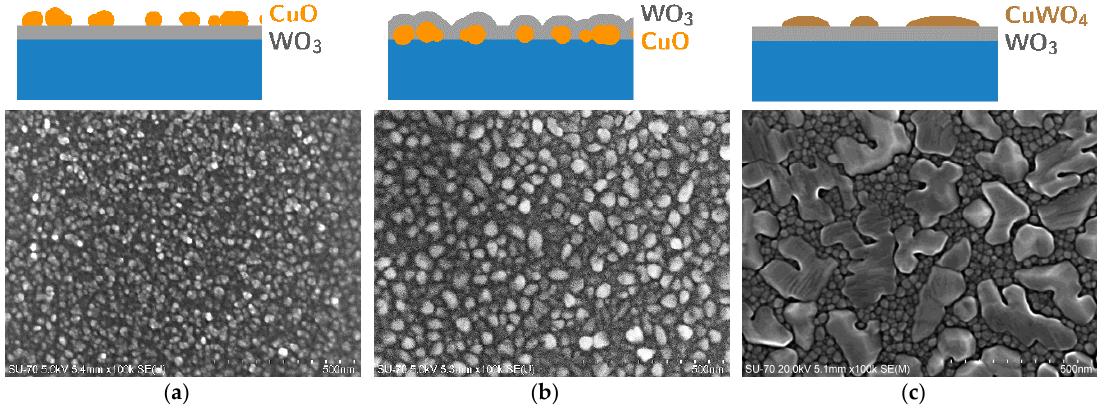
Figure 1. SEM micrographs of investigated structures. ( a ) CuO clusters on the WO 3 film; ( b ) CuO cluster covered with WO 3 film; ( c ) CuWO 4 nanostructures on WO 3 thin